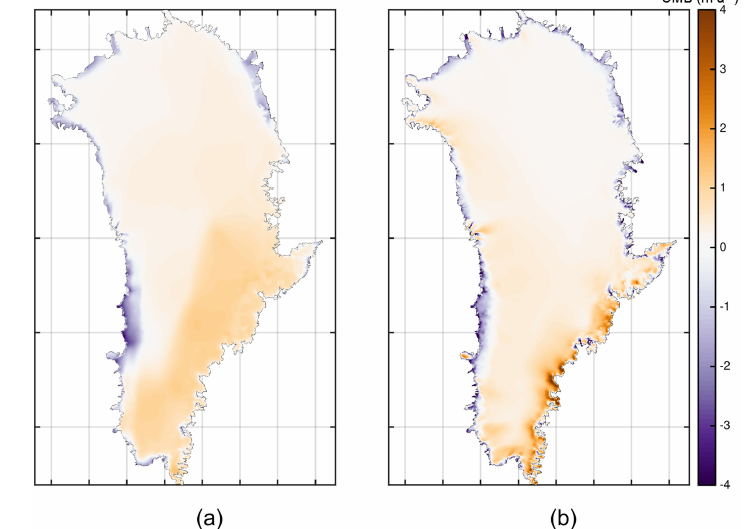
Figure 3. Comparison of surface mass balance fields averaged for the time period 1960–1990; (a) surface mass balance derived by forcing SEMIC with climate data from HadGEM2; (b) surface mass balance of RACMO2.3 (Noël et al.,